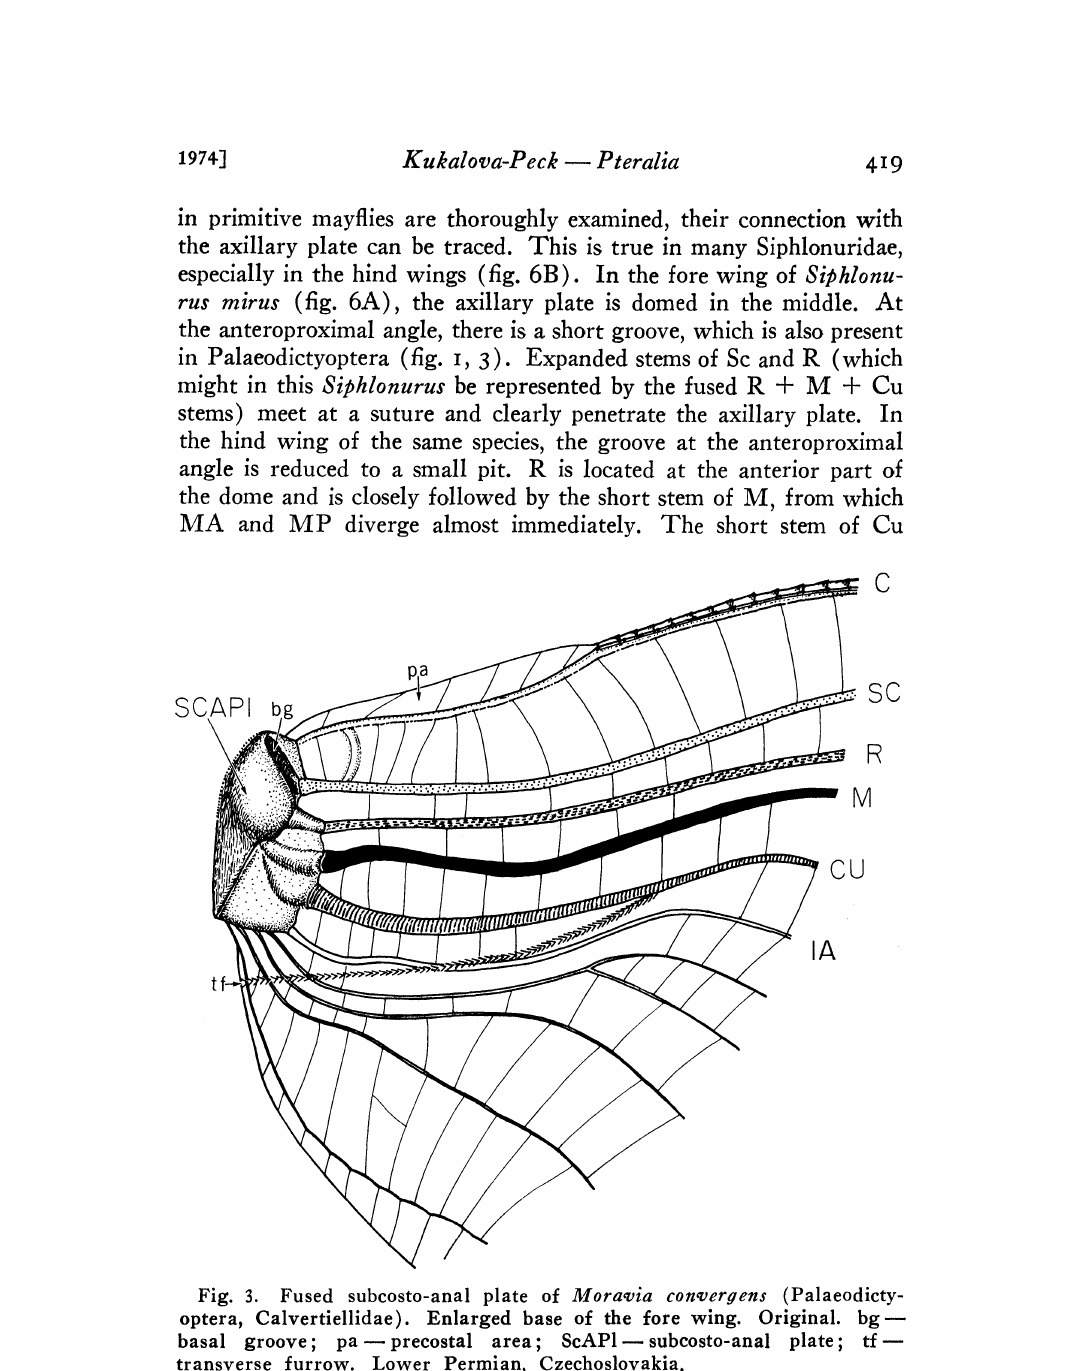
Fig. 3. Fused subcosto-anal plate of Moravia conergens (Palaeodicty- optera, Calvertiellidae). Enlarged base of the fore wing. Original. bgu basal groove; pa preeostal area; SeAP1-- subeosto-anal plate; tf transverse furrow. Lower Permian,